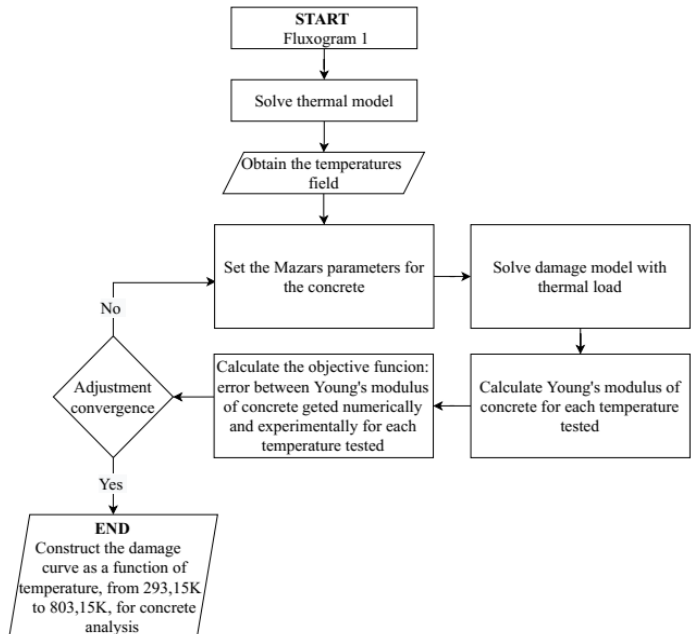
Figure 3. Flowchart 2: Thermomechanical model – obtaining the concrete’s damage evolution as a function of